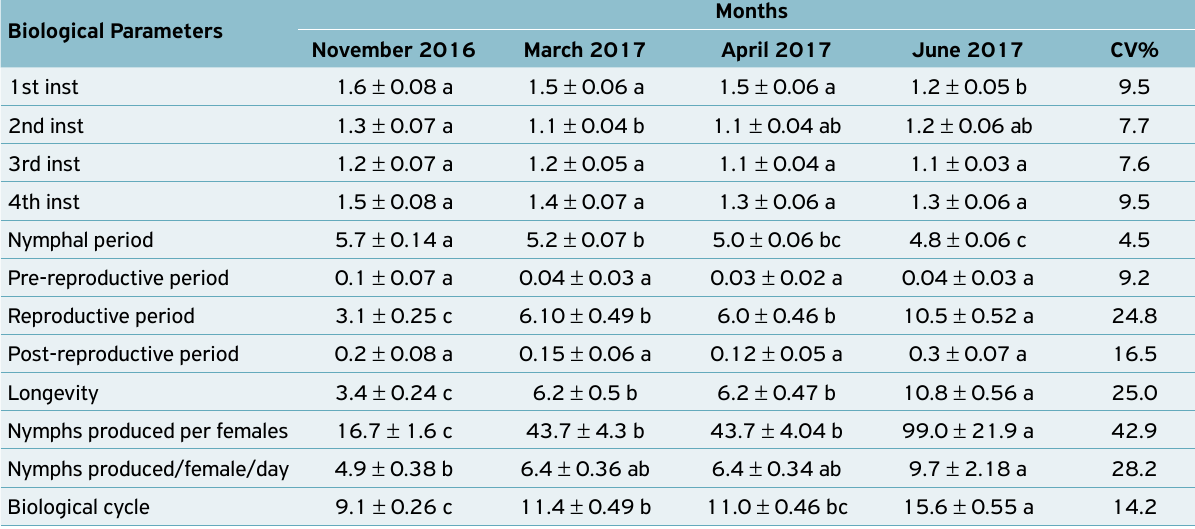
Table 1. Mean duration of developmental periods (days) and reproductive parameters of Aphis craccivora Koch. in cowpea under natural conditions. Teresina, Piauí, 2017. Biological Parameters